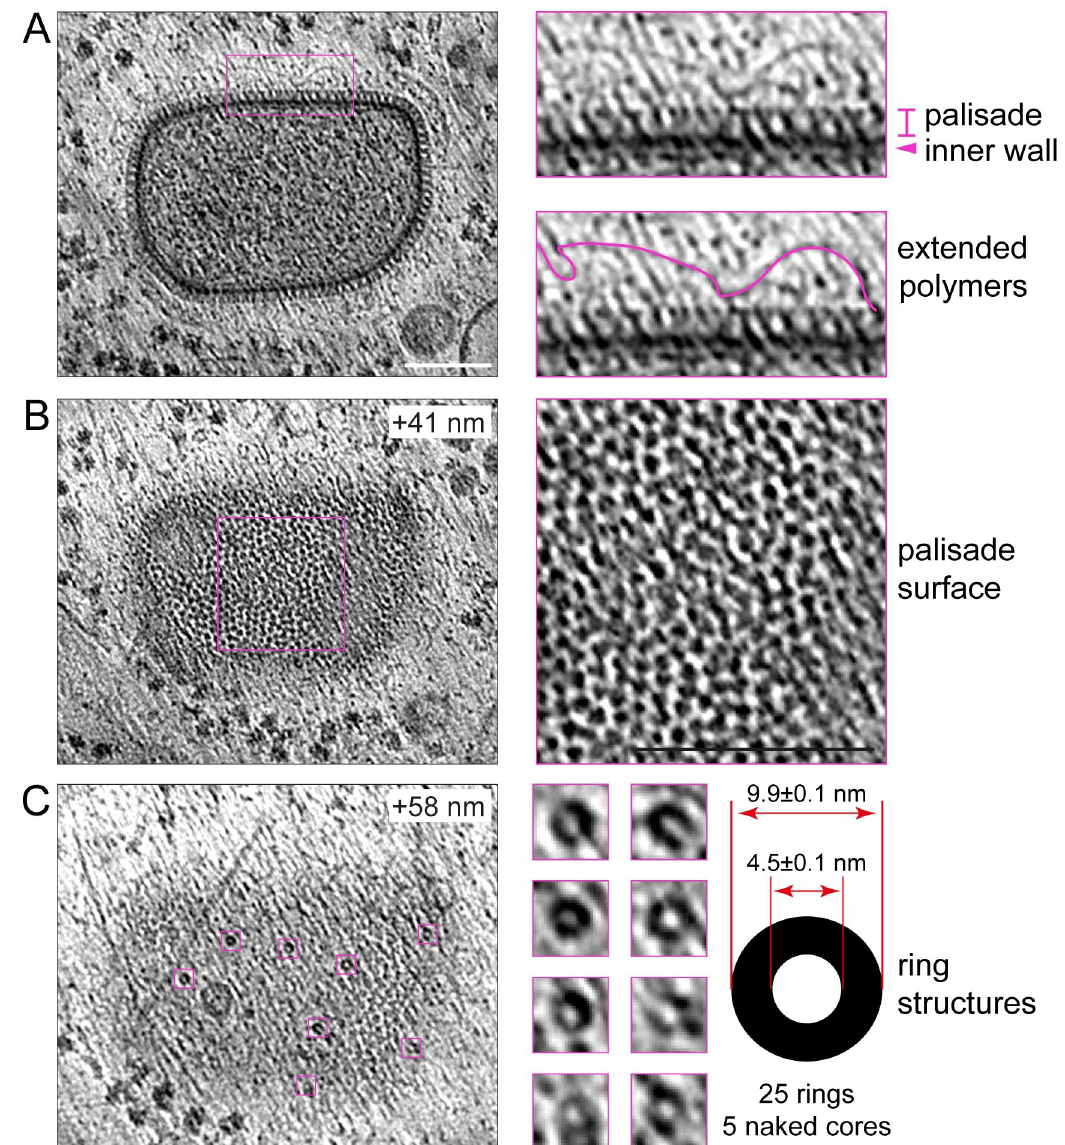
Fig 6. Ultrastructure of the naked viral core. ( A ) Middle section of a naked viral core together with a region magnified 3 times to highlight the palisade and inner wall as well as the polymers that surround the core. ( B ) A higher tomogram section (+41 nm) of the same naked viral core highlighting the pseudohexagonal lattice of the palisade. ( C ) At an even higher section (+58 nm), ring structures associated with the palisade are evident. The dimensions of the rings ( n = 25) from 5 naked cores are indicated together with the standard error of the mean. Scale bars = 100